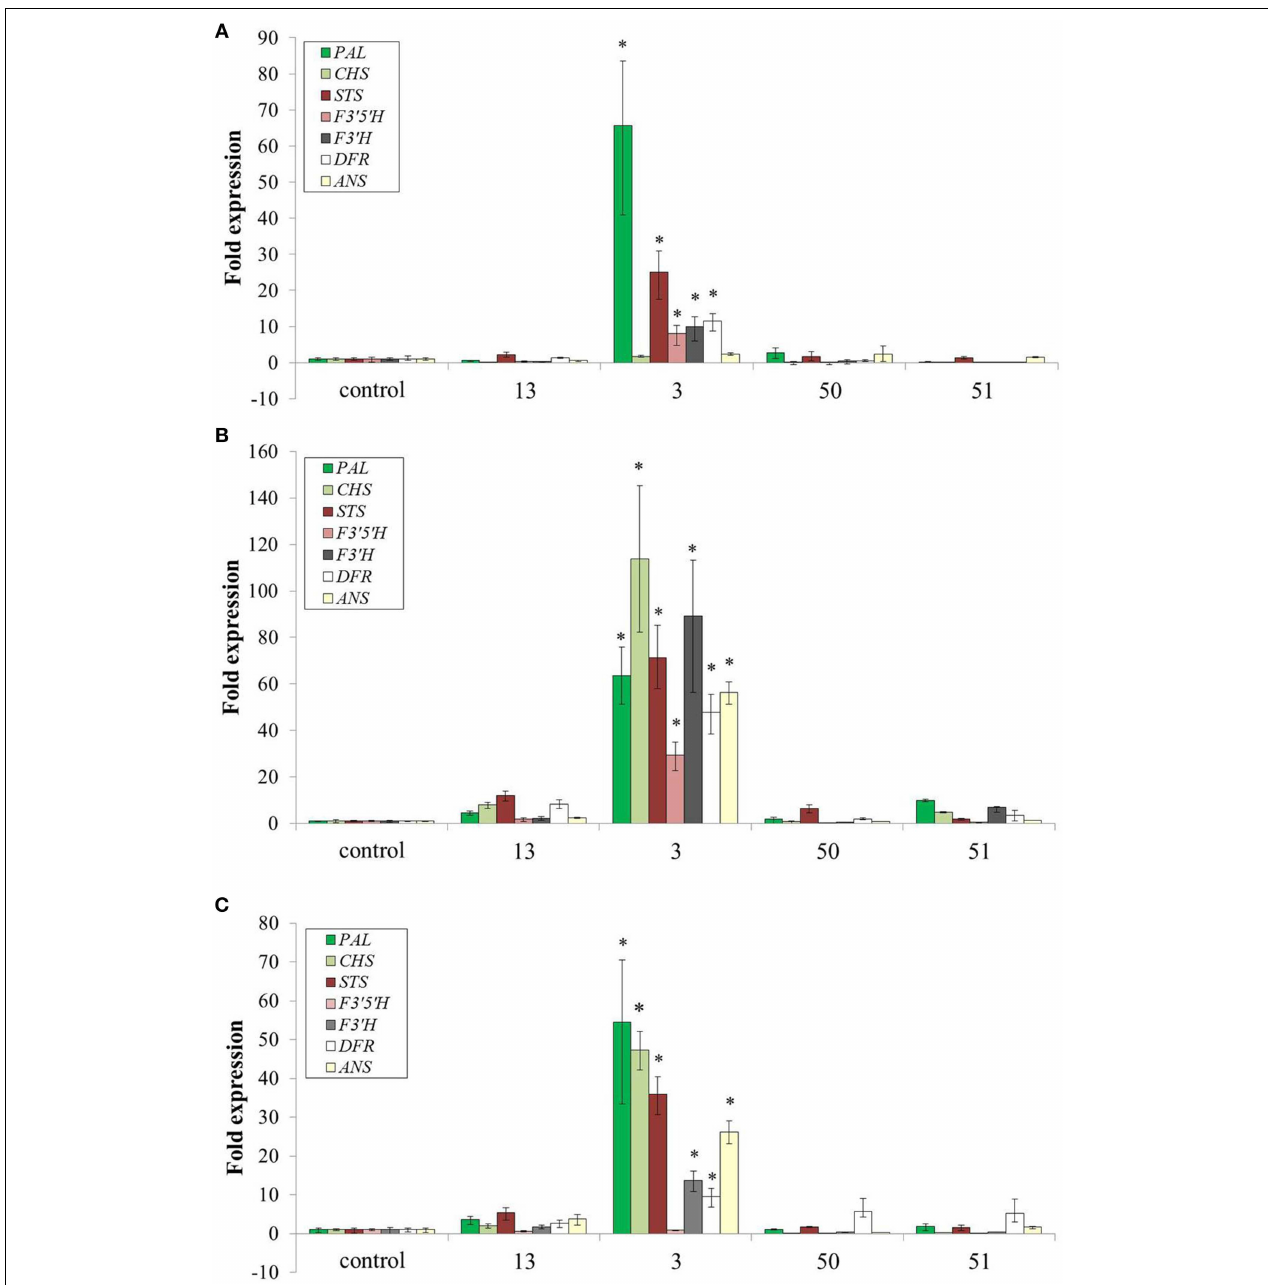
the two control lines was included (line 15). Statistical significance was analyzed by One-Way ANOVA, followed by Dunnett’s post hoc test. Asterisks indicate P ≤ 0